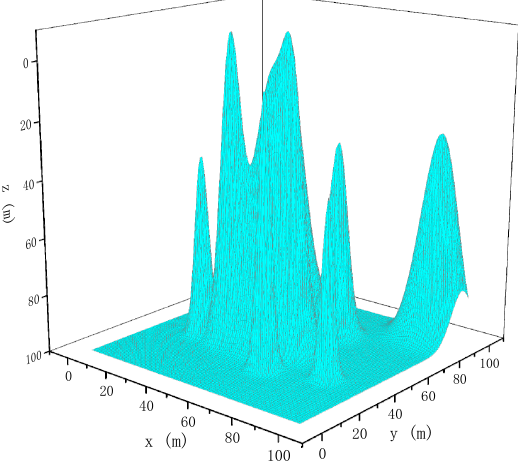
Figure 3. Simulated environment obstacles.